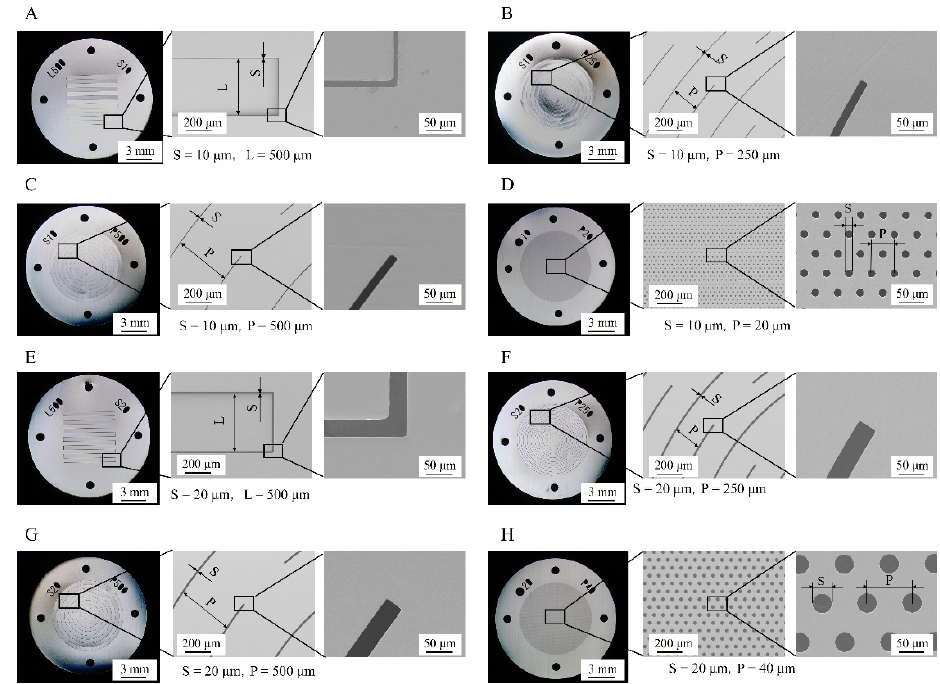
Figure 8. Improvement of the photolithography process. ( a ) After resist coating, the resist at the edge of the substrate is thick at approximately 60 µm. ( b ) Resist at the edges is physically removed after improvement. The thickness of the resist is uniform at 30 µm. There is no gap between the mask and substrate in the contact exposure.